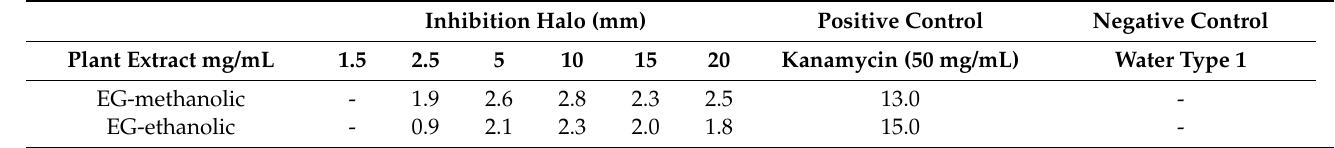
Table 4. Antimicrobial screening test of the effective extract against E. coli DH5- α . Inhibition Halo (mm) Positive Control Negative Control